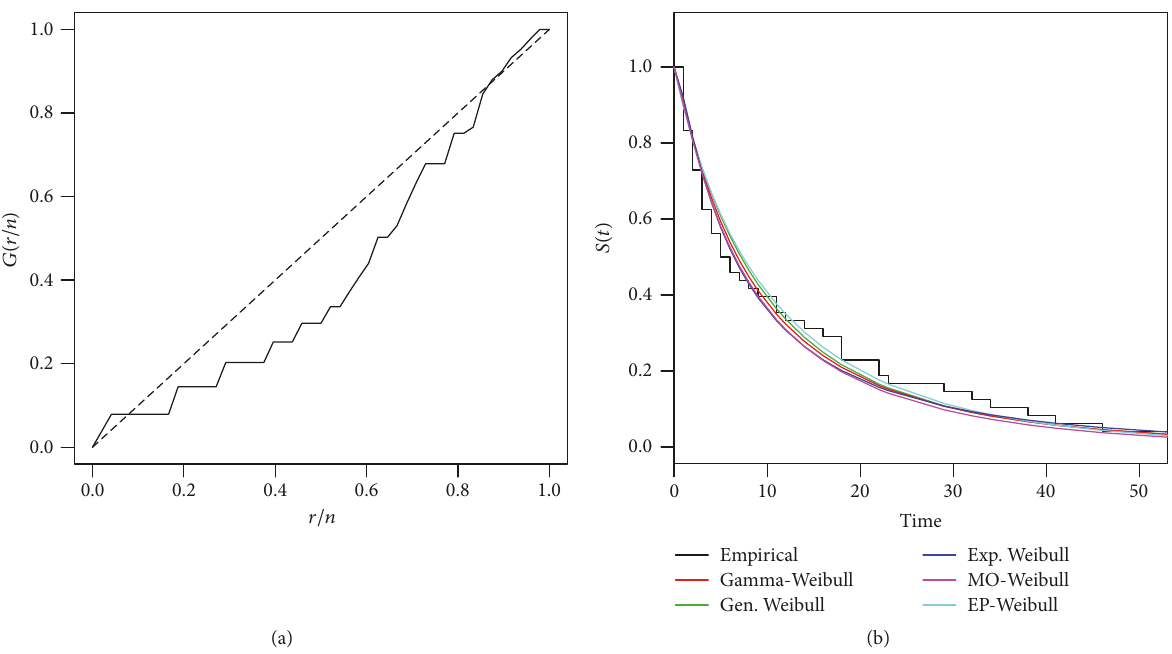
Figure 2: Pricker A empirical (a) TTT-plot, and (b) contains the fitted survival superimposed to the empirical survival function and the hazard function adjusted by distribution.